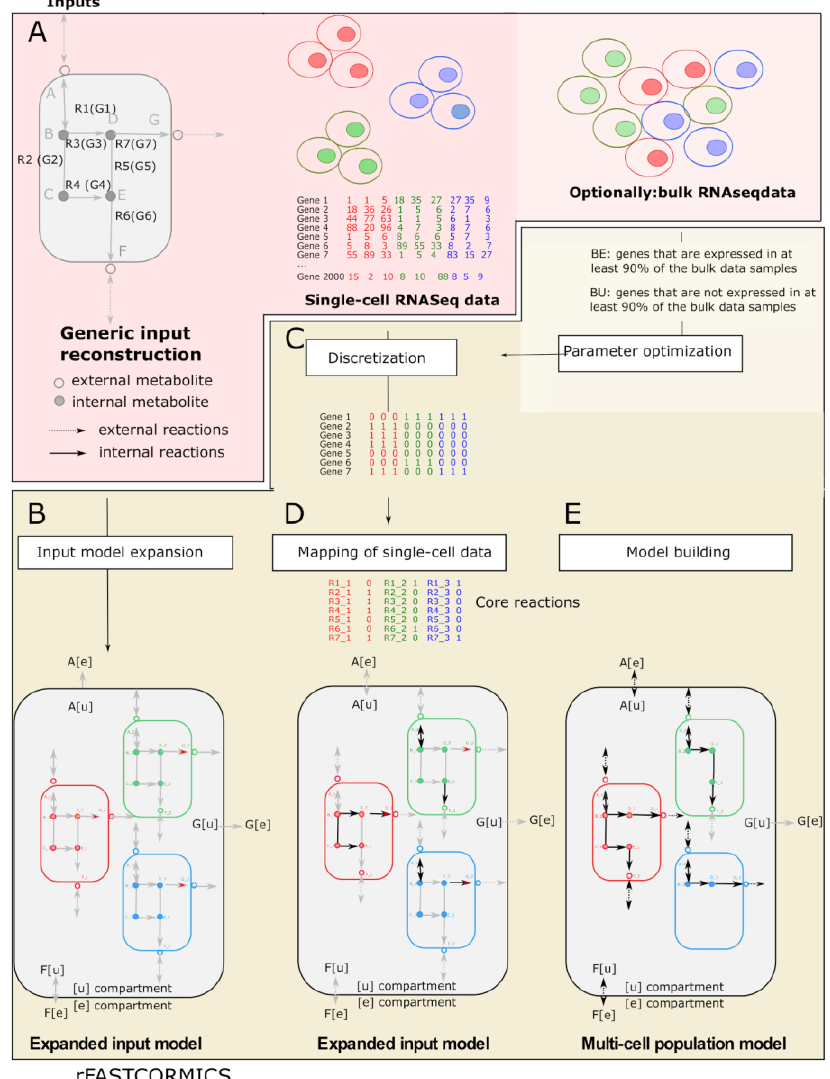
Figure 1. Workflow: The inputs of scFASTCORMICS are a generic model; in the paper, Recon3D, (gray box in panel ( A ), metabolites and reactions are represented in circles and arrows, respectively) single-cell data and optionally medium constraints and bulk RNAseq data from the same context. Generic reconstructions or models contain every metabolic reaction described in an organism regardless of the context or cell type. The generic model has internal reactions (not connected with the environment, dotted arrows) and external reactions (connected with the environment, solid arrows). To create an expanded input model (large grey box in panel ( B – D )) that accounts for the dataset’s different populations (colored boxes in the large grey box), a set of internal reactions is created for each population by duplicating the internal reactions of the generic model. The exchange reactions between the system and the environment in Recon3D are transformed into transporter reactions to the microenvironment in the expanded input model. The reversibility of the reactions is conserved. In other words, the sub-models corresponding to the cell populations can import and export the same metabolites as Recon3D. The external metabolites [e] (transparent circle) of Recon3D are converted into [u] metabolites ([u] standing for microenvironment). A set of reversible transporters and exchange reactions are added to the model to transport these metabolites between the microenvironment and the external compartment and to allow them to enter and exit the system. The microenvironment allows metabolite exchanges between the population sub-models (red, green, and blue boxes). The